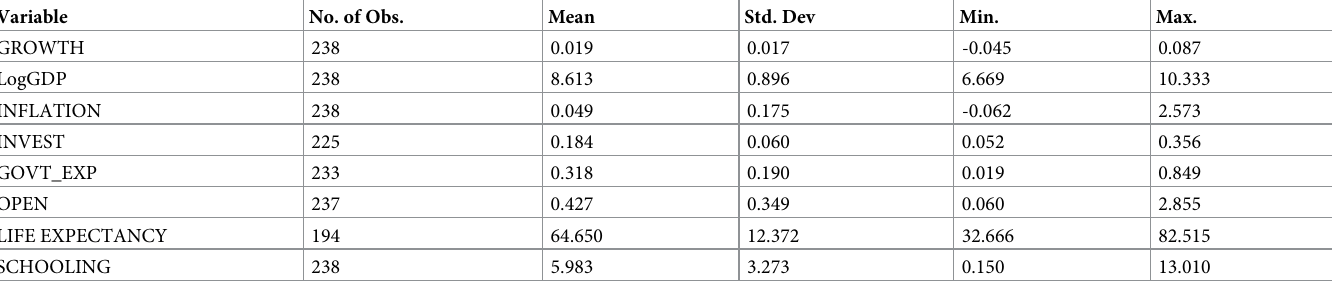
Table 2. Descriptive statistics.